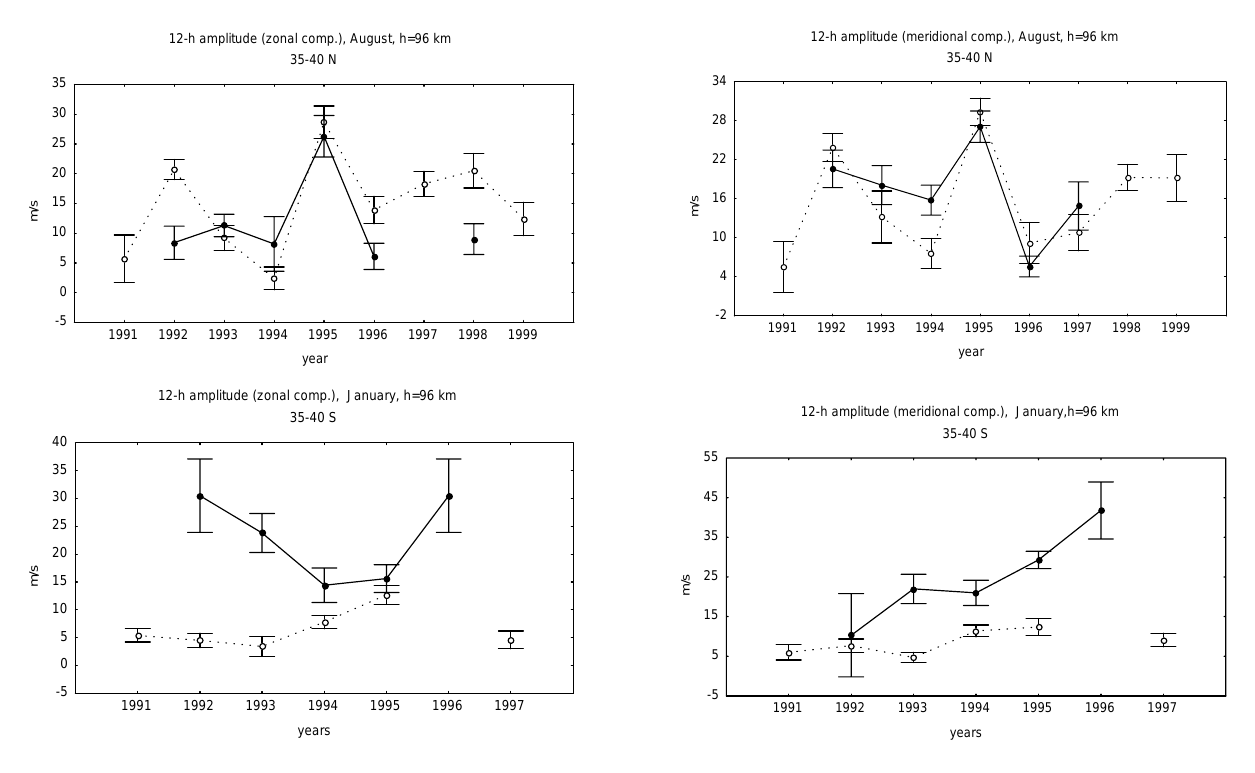
Fig. 14. Same as Fig. 12, except for amplitude of semidiurnal tide. Fig. 15. Same as Fig. 13, except for amplitude of semidiurnal